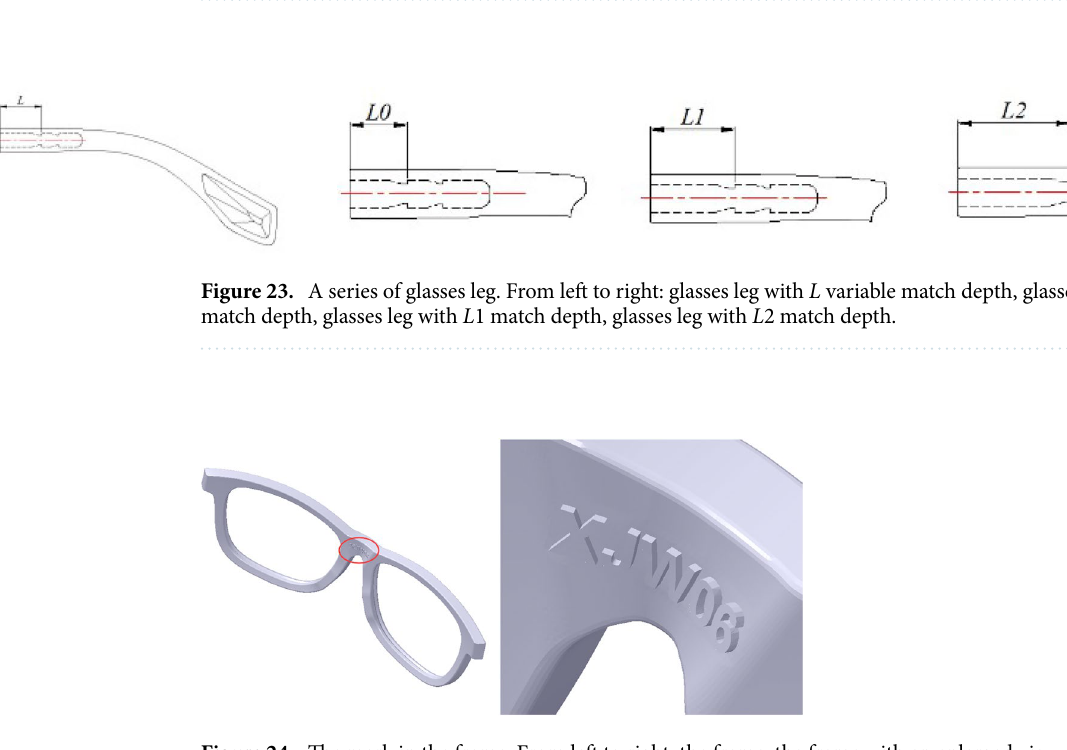
Figure 24. The mark in the frame. From left to right: the frame, the frame with an enlarged